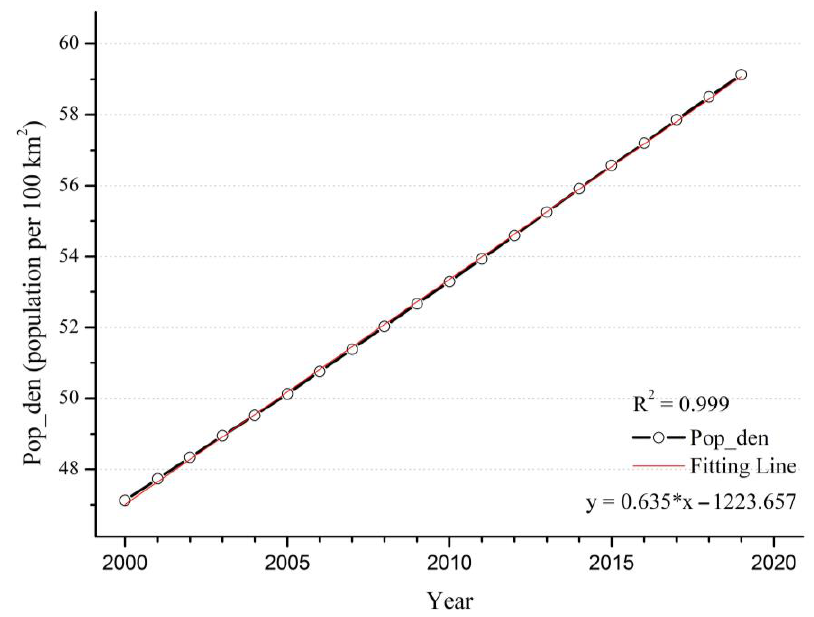
Figure 11. Time series of global mean population per 100 km 2 from 2000 to 2019.